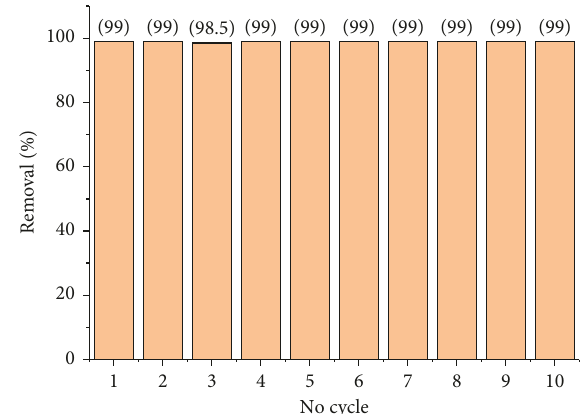
Figure 17: The cyclic adsorption performance of the adsorbent GO against F −